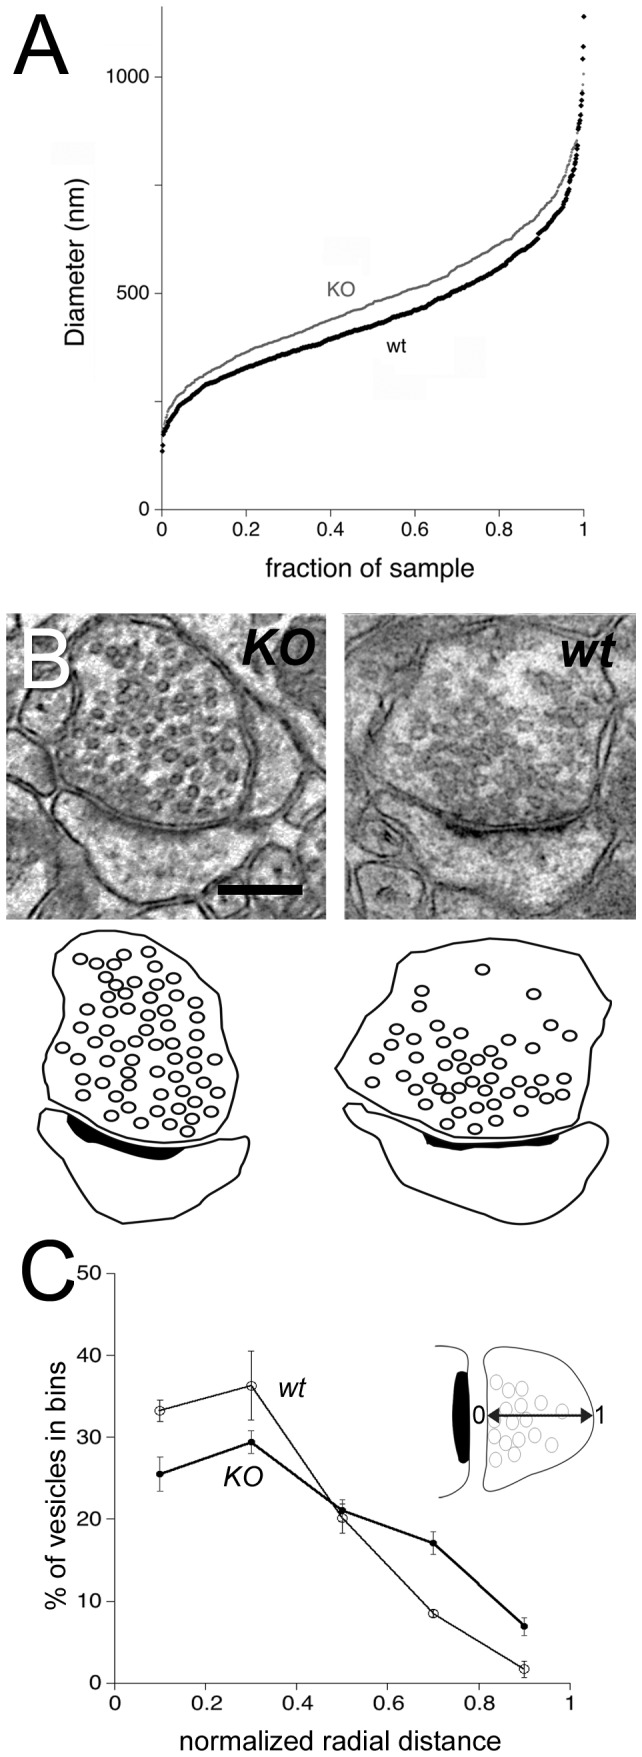
WAVE-1 affects size of presynaptic terminals and organization of synaptic vesicles.
A. Cumulative plot shows the distribution of the mean diameter (defined as sqrt(area*4/π)) of terminals in KO (grey circles) and wt (black diamonds) CA1 KO terminals are generally larger than wt terminals. B. Electron micrographs (upper panel) and corresponding line drawings (lower panel) illustrate organization of synaptic vesicles within an axon terminal from a KO mouse (left), compared to wt control (right). Micrographs are from stratum radiatum of CA1 hippocampus. Synaptic vesicles are more numerous and lie farther from the active zone in KO mice, compared to wt. Scale bar: 200 nm. C. Quantitative analysis of the organization of vesicles in KO mice, versus wt controls. To combine data from terminals of different sizes, the distribution of vesicles was normalized (see inset): 0 corresponds to a vesicle lying directly at the presynaptic membrane, and 1 to a vesicle lying at the opposite non-synaptic membrane along an axis perpendicular to the synapse. Black circles (representing positions of KO vesicles in terminals) tend to lie farther from the active zone than white circles (representing positions of the wt vesicles). Vertical bars are standard errors (N = 3 animals for each genotype).